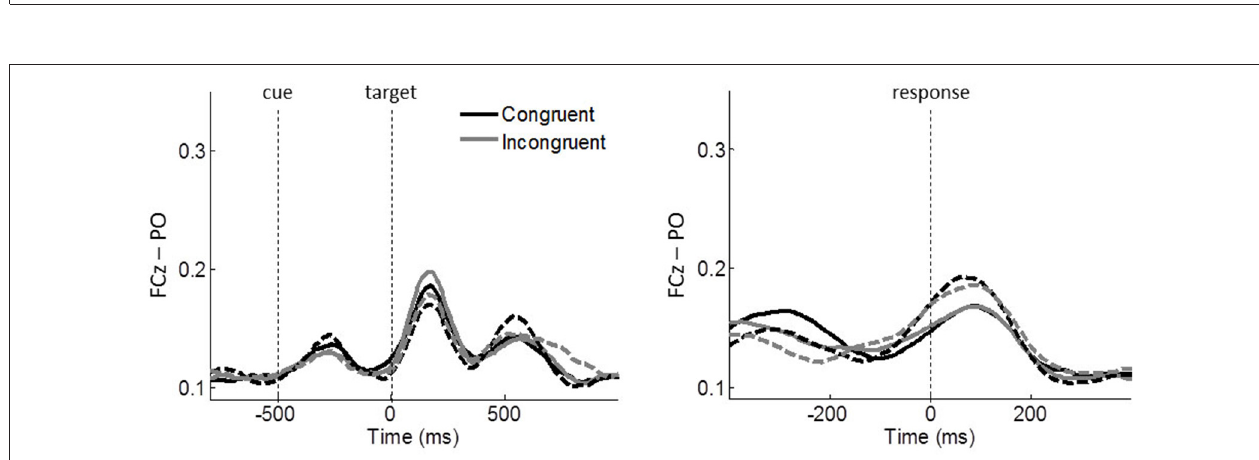
FIGURE 6 | Motor-related ICPSs between FCz and CP3/4 in theta oscillations. Left panel shows the topographical maps average of 100 ms around the response onset for the right and left target trials. White dots represent the seed electrode FCz and black circles indicate electrodes CP3/4 over the motor cortex. Right panel shows FCz-seed contralateral and ipsilateral ICPSs to the responding hand. Solid and dashed lines represent controls and meditators, respectively.